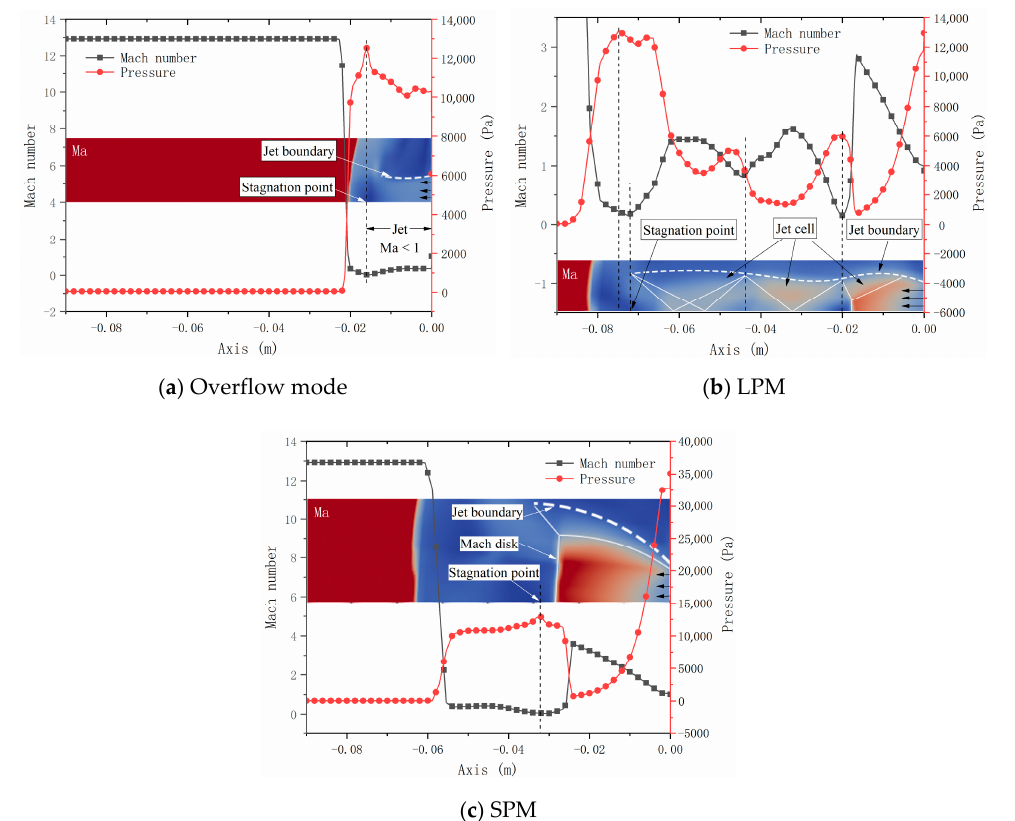
Figure 10. Mach number, pressure, and jet structure of three jet modes.